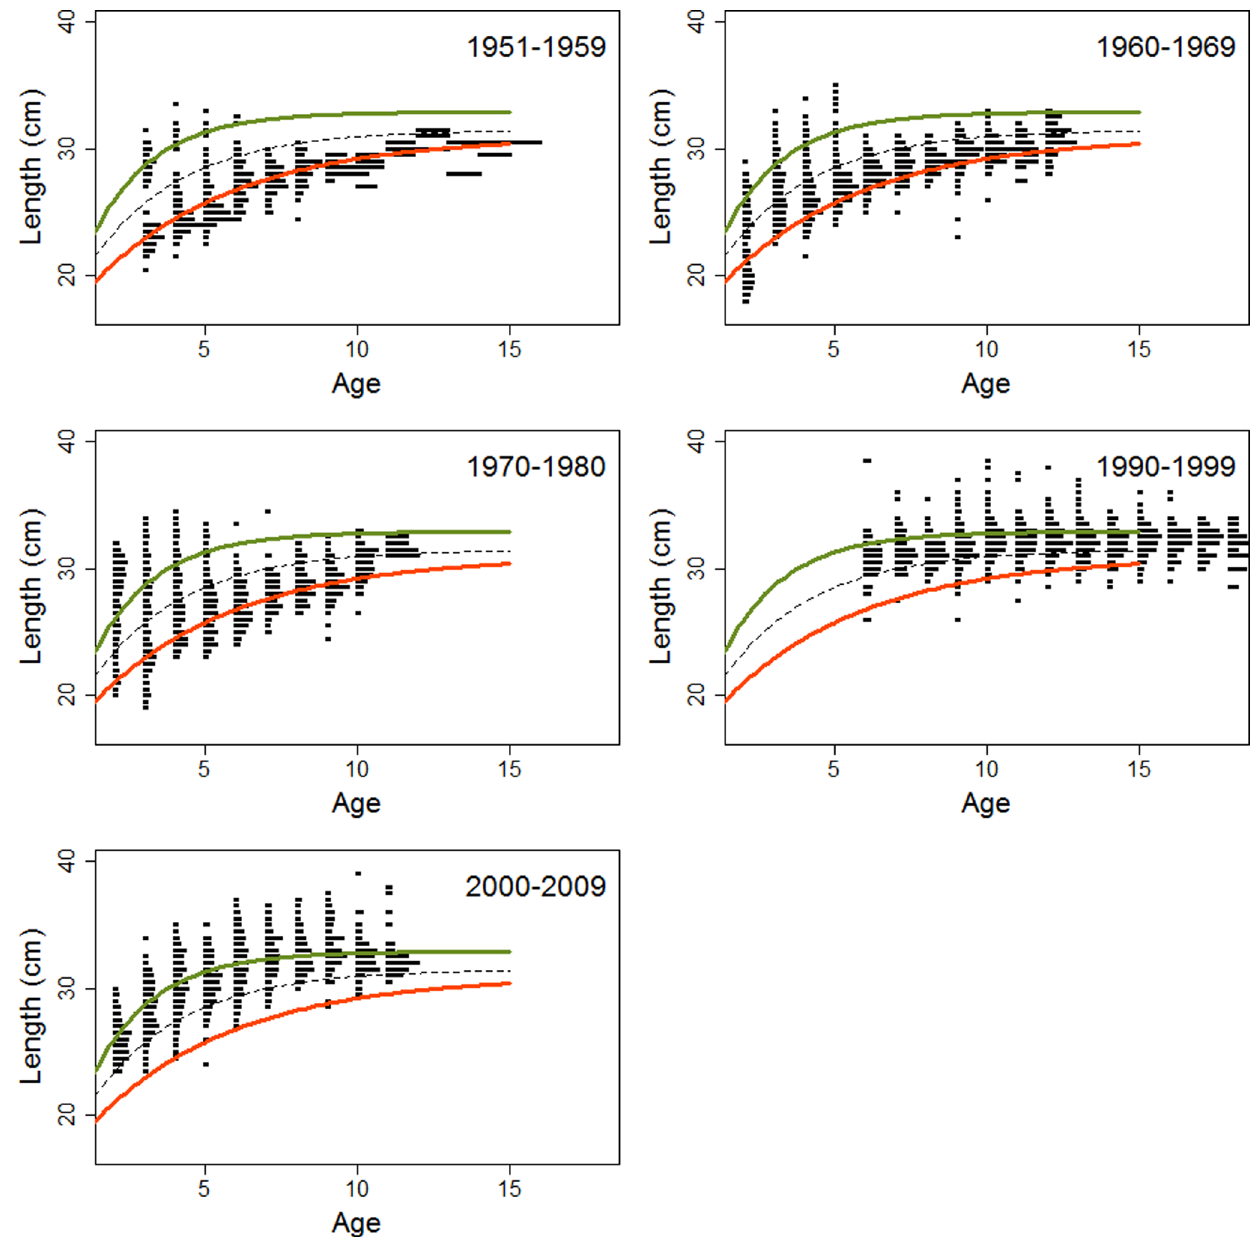
Figure 3. Length-at-age. Histograms averaged for herring YCs of the 1950s, 1960s, 1970s, 1990s and 2000s. A von Bertalanffy growth curve is fitted for the 1950s (red) and for the 2000s (green), and the dotted curve marks the midpoint between the two fitted curves.